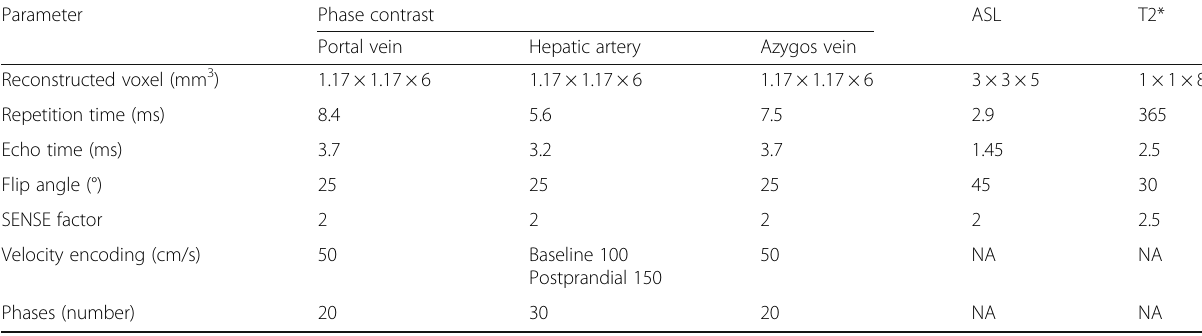
Table 1 Magnetic resonance parameters for blood flow assessment using phase contrast magnetic resonance imaging, liver perfusion measures using arterial spin labelling (ASL) and transverse relaxation (T2*) mapping of the